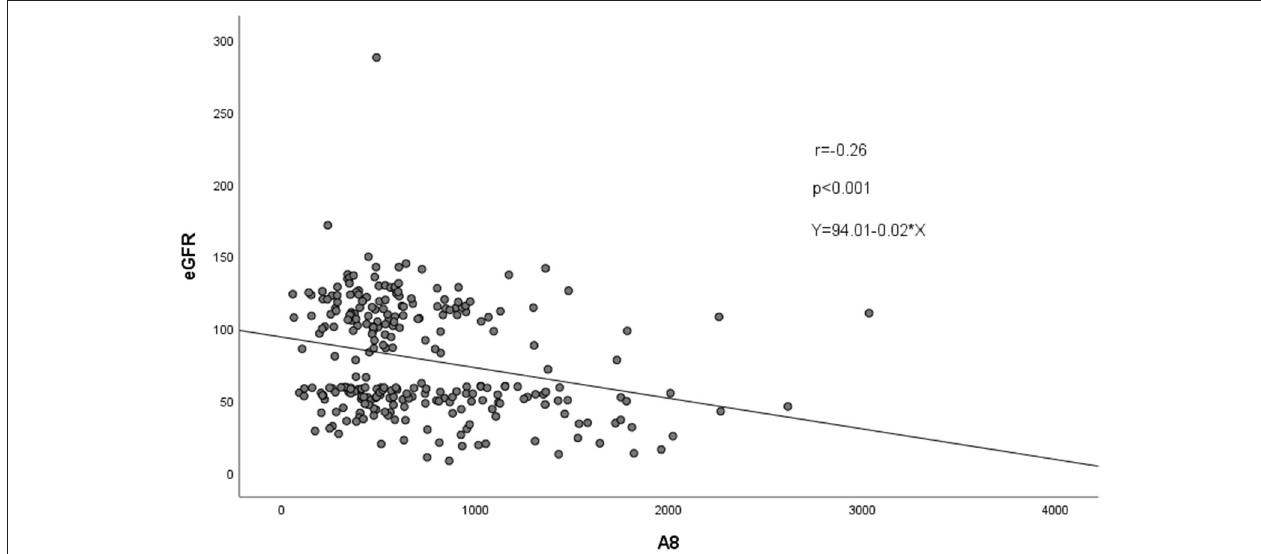
FIGURE 1 | Scatter and linear plots of ANGPTL8 levels and renal function.